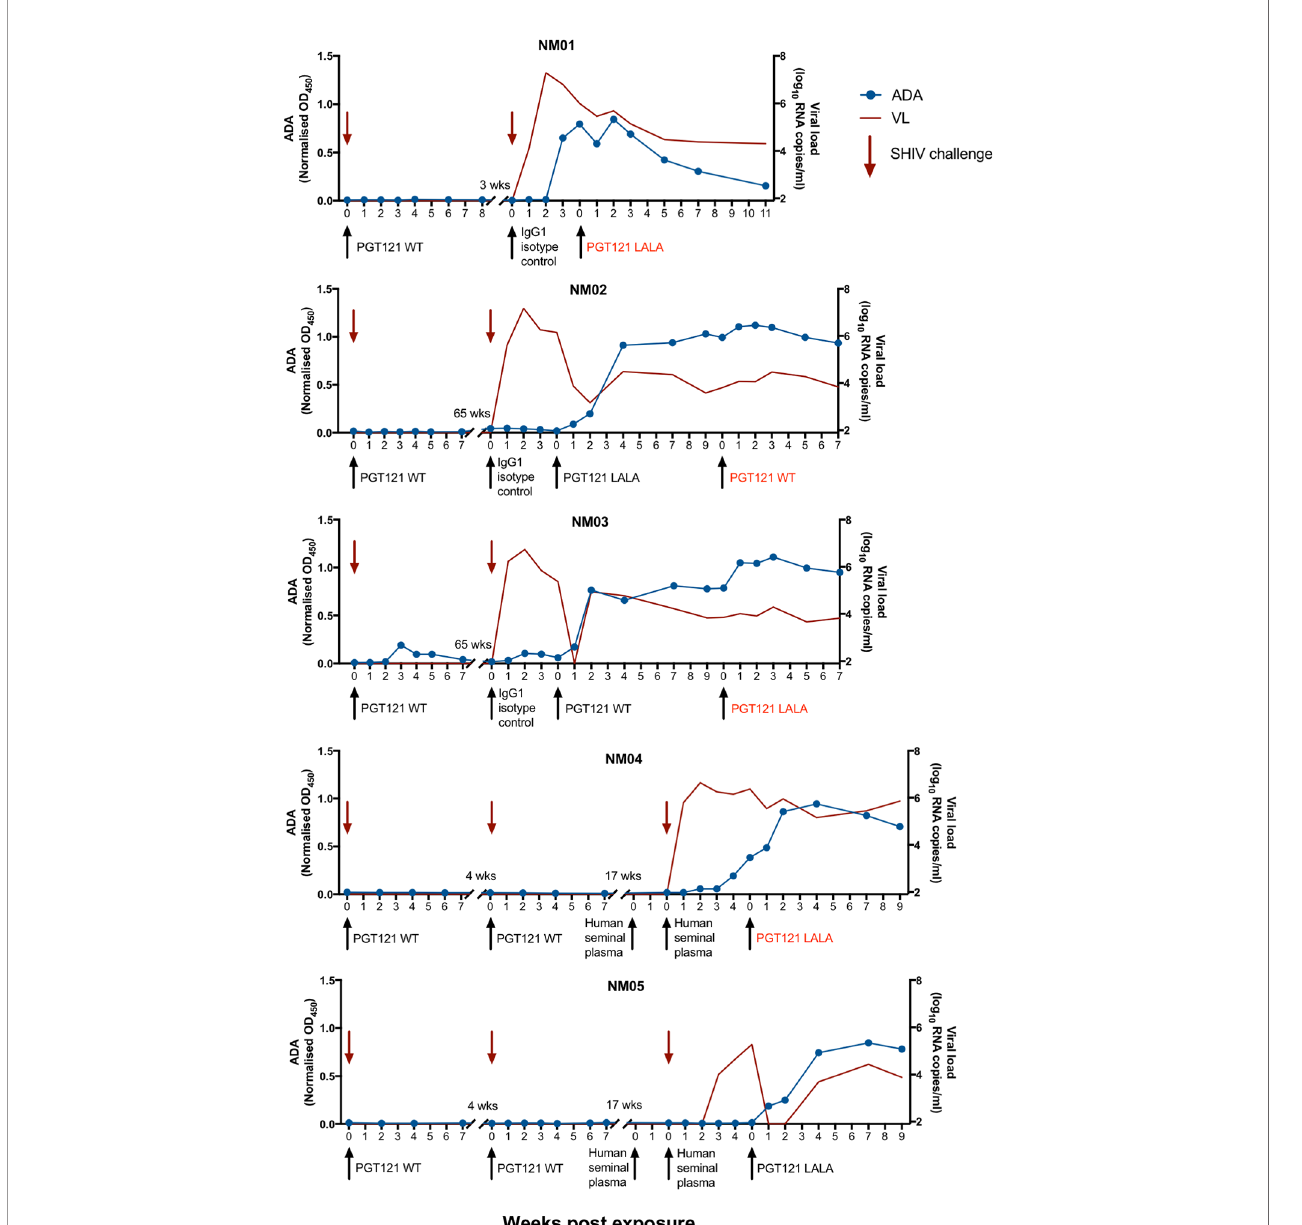
FIGURE 1 | Anti-PGT121 antibodies develop in pigtailed macaques following exposure to human antibodies. Five pigtailed macaques were administered PGT121 or a human IgG1 isotype control antibody intravenously (1mg/kg) prior to challenge with cell-free or cell-associated SHIV. Macaques NM04 and NM05 were administered human seminal plasma either intrarectally or both intravaginally and intrarectally prior to intrarectal challenge with SHIV. Viraemic animals were then infused with PGT121 with either WT or LALA Fc. Macaque anti-PGT121 ADA are shown in the blue line (left y-axis) while SHIV viral loads are shown in the red line (right y-axis). Black arrows indicate antibody administration while red arrows indicate SHIV challenge. The red text indicates failed therapy with PGT121 WT or